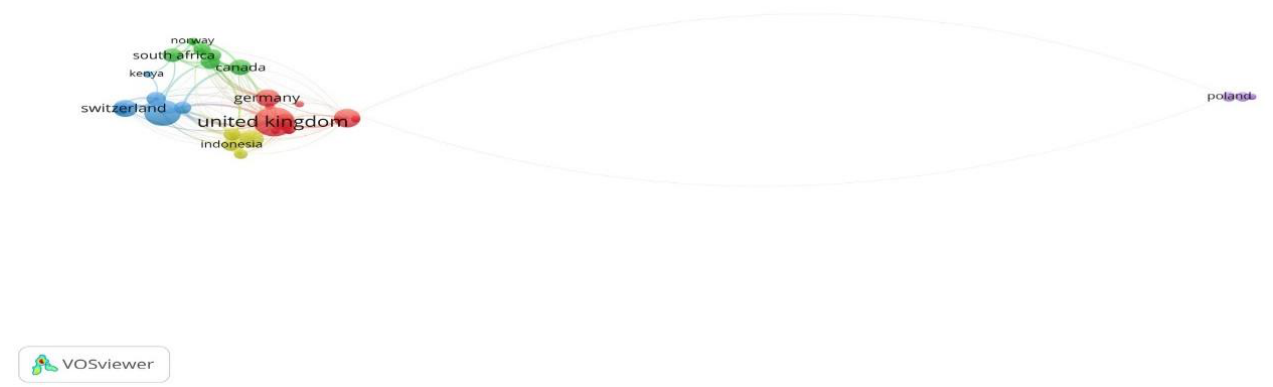
Figure 5. Country-wise searched result of keywords.